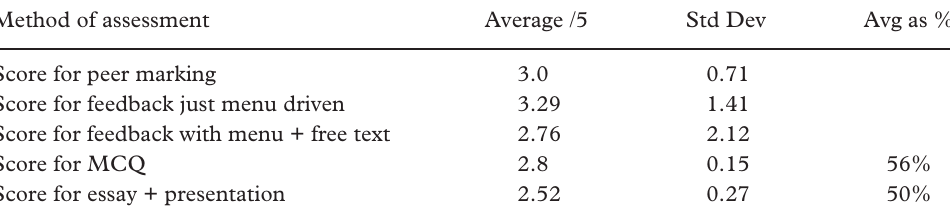
Table 6. Average results for assessments